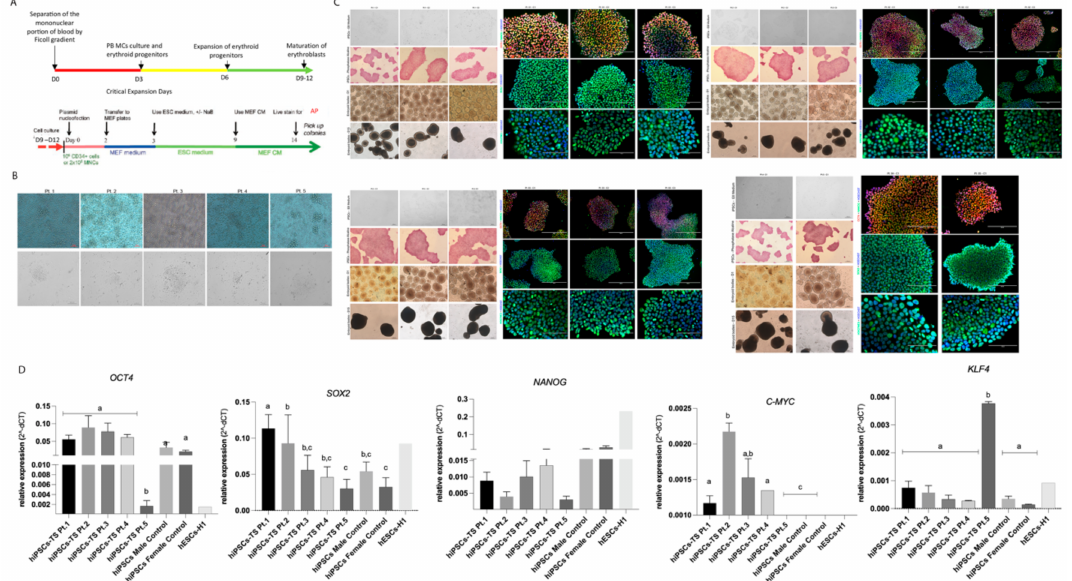
Figure 1. The process of reprogramming of Turner syndrome PBMCs into hiPSCs and characterization of hiPSCs-TS and colonies. ( A ) Schematic protocol used to reprogramming PBMCs into hiPSCs. ( B ) PBMCs with ten days of expansion in a specific medium for enrichment erythroblastic populations; the emergence of the first hiPSCs-TS colonies maintained in hESCs medium on MEF. ( C ) Characterization of hiPSCs-TS of Pt.1, Pt.2, Pt.3, Pt.4 and Pt.5. Phase contrast image showed hiPSCs maintained in mTeSR-1 medium on Geltrex; positively stain of alkaline phosphatase; Immunofluorescence assay showed the presence of pluripotency markers OCT4, SOX2, NANOG. Nuclei were stained with Hoechst (blue). Scale bars s: 200 µ m and 100 µ m. The data was compiled from at least three technical replicates. ( D ) Quantification of the relative expression of OCT4 , SOX2 , NANOG , KLF4 , and c-MYC genes in all hiPSCs lines and subclones (p15). Individual quantifications by qRT-PCR were normalized using the B-ACTIN gene. The ESCs-H1 line was used as a positive control and was not considered in the statistical model. All qRT-PCR from hiPSCs-TS and control data were compiled from at least three biological and technical replicates. p values were calculated by Two-way ANOVA, followed by Tukey’s multiple comparisons test as appropriate (letters a-b-c show difference between groups). Erros bars denote represent